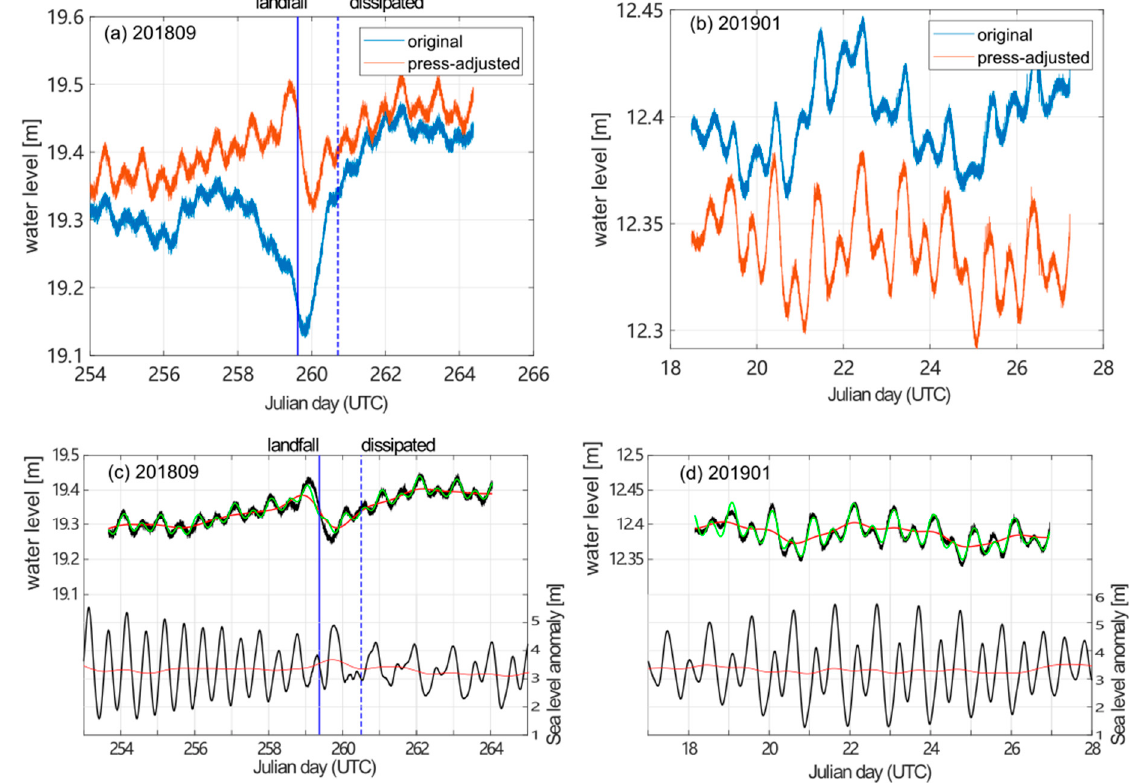
Figure 2. Surface water level inside Huguangyan Lake ( a , b ) and sea level time series from a tidal gauge in a nearby estuary in September 2018 and January 2019. The upper panels ( a , b ) show the original records of water level (blue lines) and those after the barometric pressure adjustment (red lines); the lower panels ( c , d ) illustrate the pressure-adjusted water depth in the lake (upper portions) and sea level records at the tidal gauge (lower portions). The black lines in ( c , d ) are pressure adjusted records, red lines are the 40-h low-pass filtered results, green lines are the reconstructions of harmonic analyses.